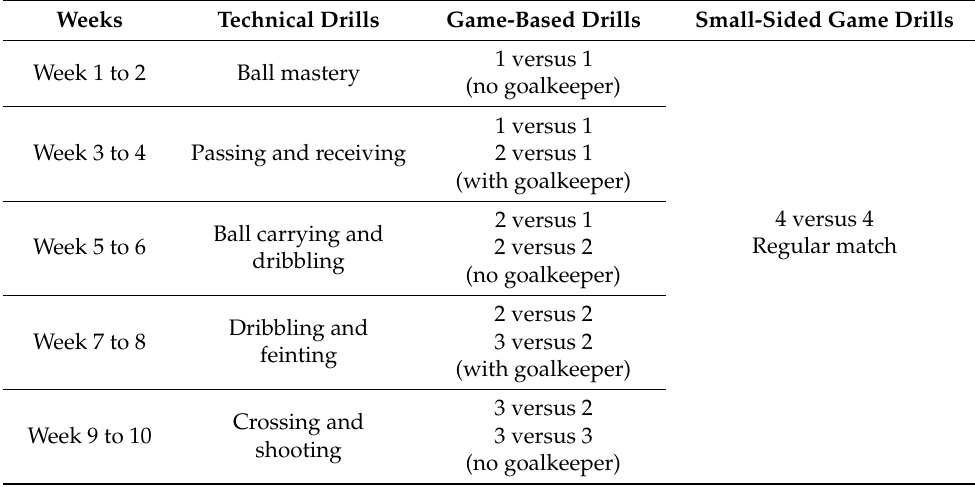
Table 2. Training content of the 10-week intervention performed by the SSG. Game-Based